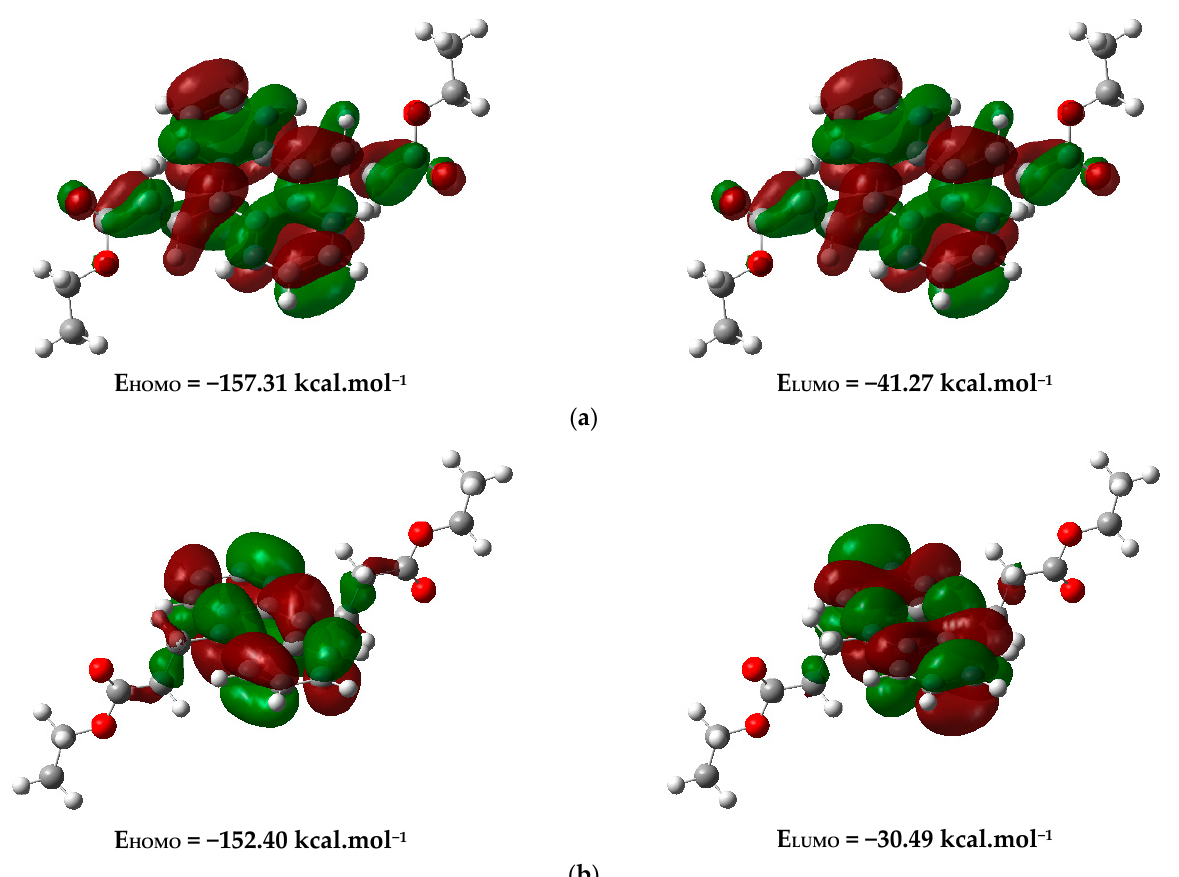
Figure 11. Frontier orbitals HOMO and LUMO for the ( a ) DADB and ( b ) DEADP molecule, obtained by DFT/M06-2X/6- 311G++(2d, 2p) level of theory.